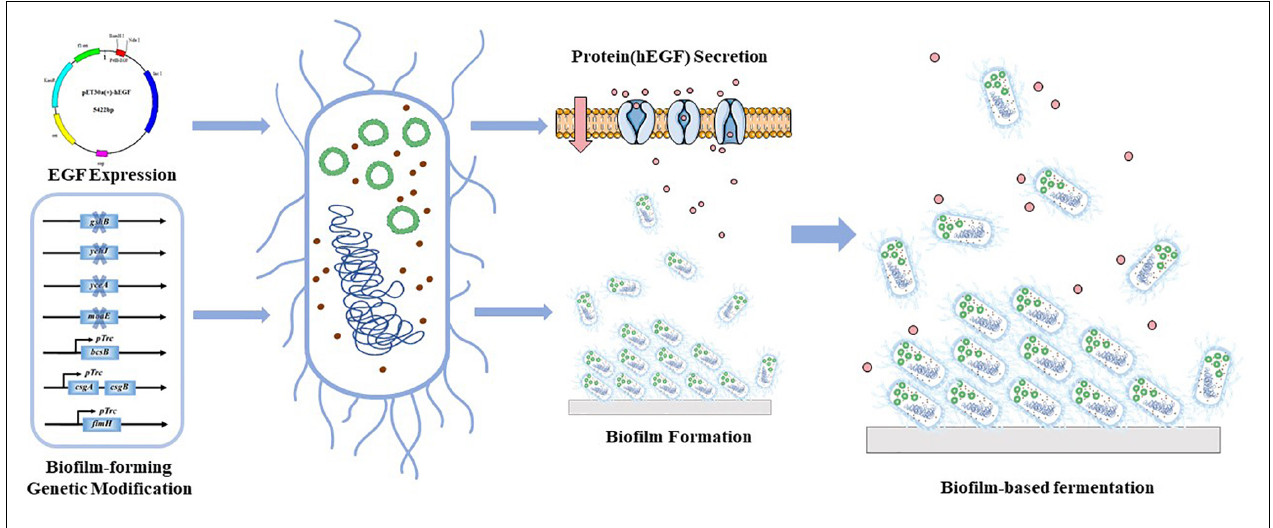
FIGURE 1 | A graphical illustration of biofilm-based secretion of hEGF in this